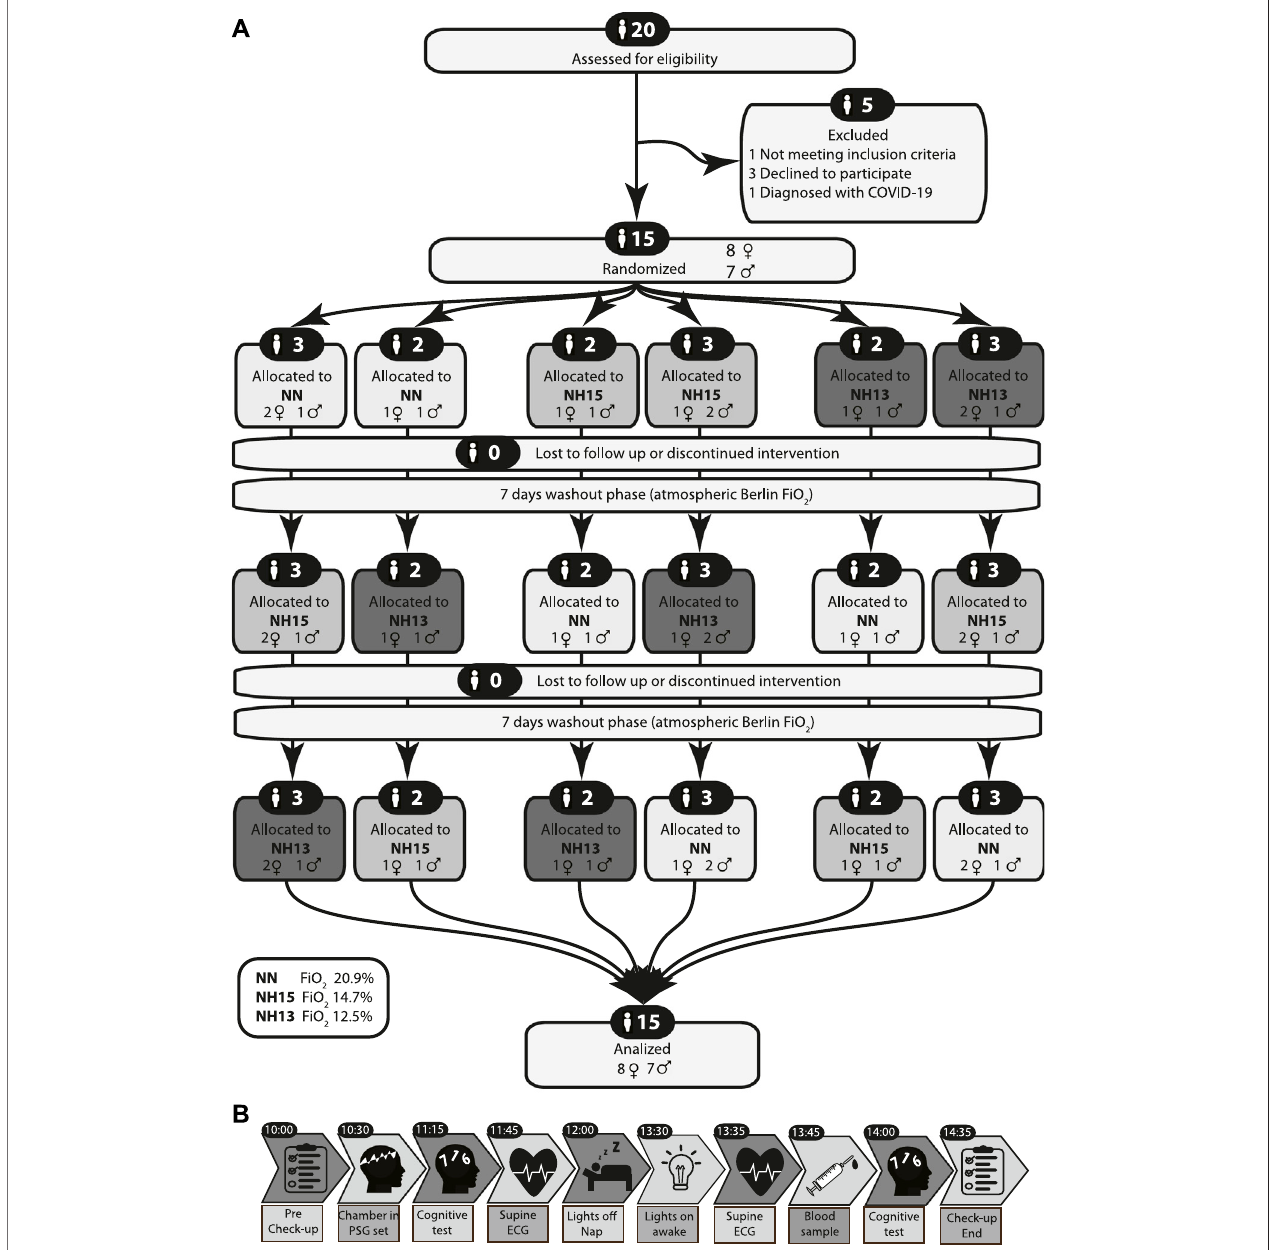
FIGURE 1 | CONSORT 2010 fl ow diagram (A) and study protocol (B)